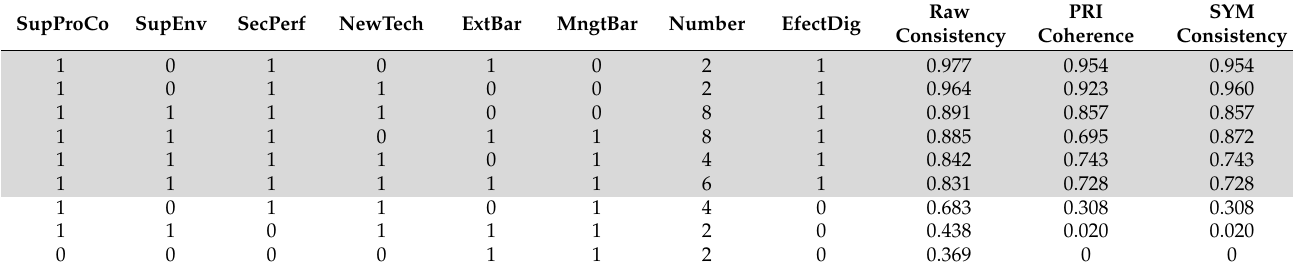
Table 4. fsQCA results: truth table.